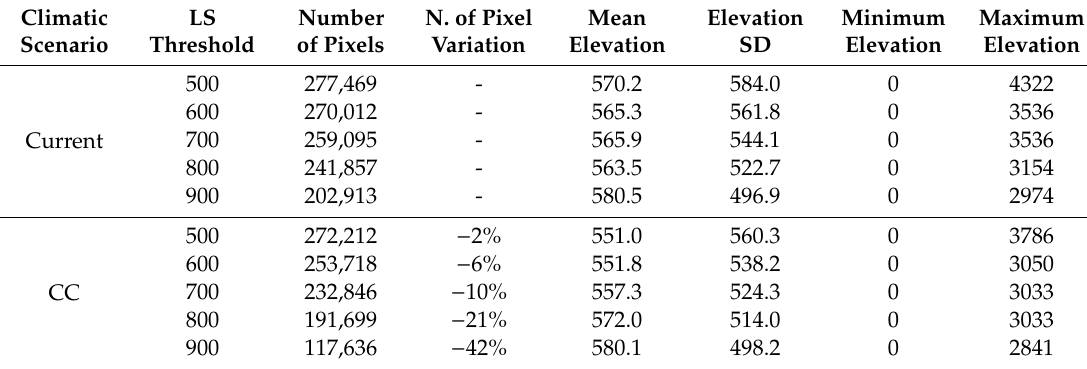
Figure 4. Maximum suitability values grouped by altitudinal envelopes (100 m) across the whole country ( left ) and on the 7272 INFC2005 inventory plots only ( right ). In the last two pictures on the bottom, boxplots were colored according to the average value if below (red) or above (green) zero, expressing on average a decrease or increase of LS values, respectively, for the total forested area in the studied country. Table 2. Maximum number of pixels that exceed of di ff erent threshold level and values of mean, standard deviation, minimum, maximum of